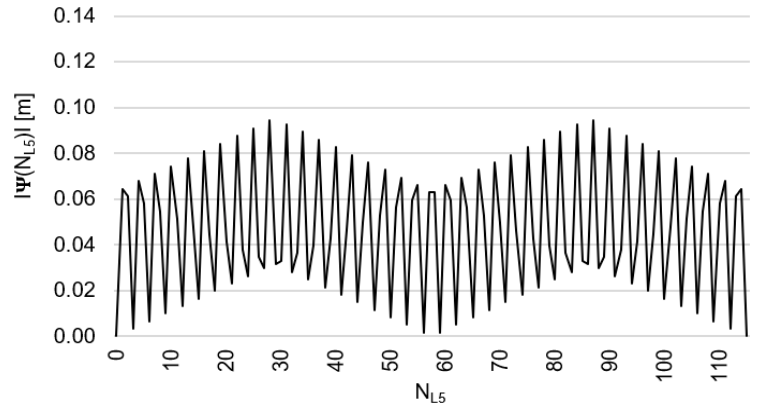
Figure 3. Behavior of a full period of the (cid:3627)Ψ(𝑁 (cid:3013)(cid:2869) ) (cid:3015) N L 1 ∈ < 0;154 > interval, for GNSS observations and frequencies L1 / E1 and L5 / E5a.